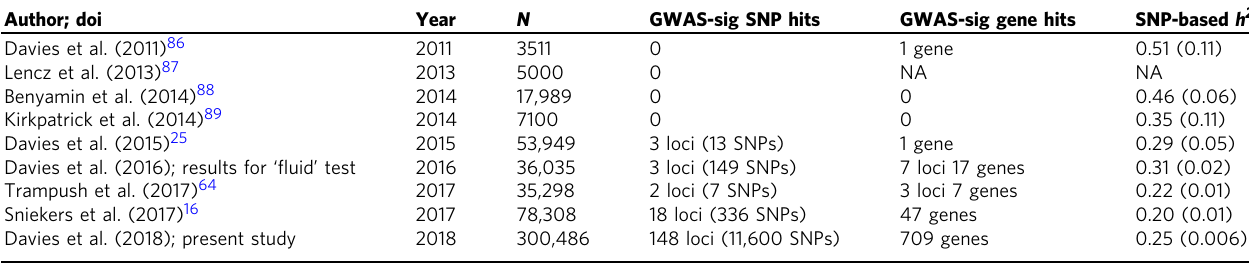
Table 1 Details of GWA studies of general cognitive function to date, including the present study Author;